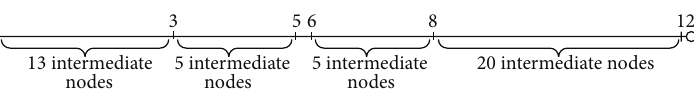
Figure 9: An illustration of a path from station 1 to station 12.